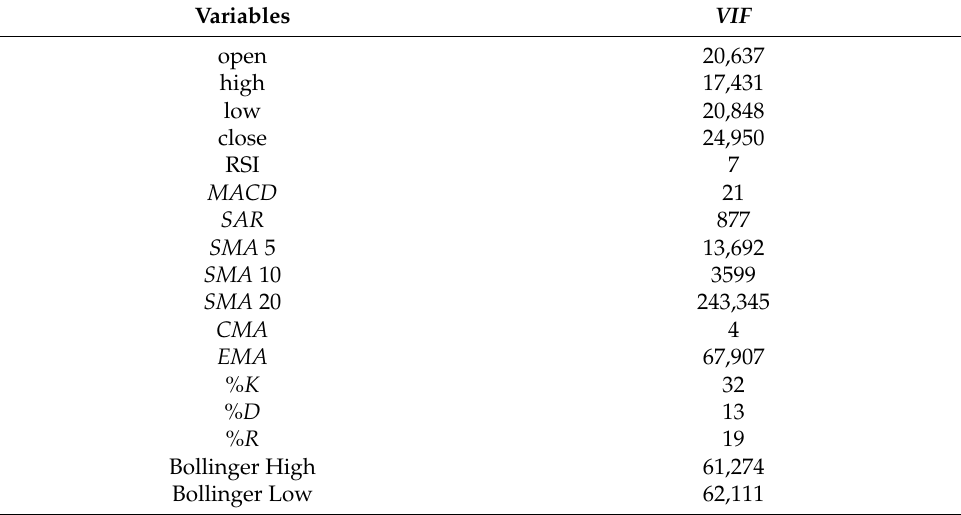
Table 1. Variation Inflation Factor Analysis for EUR/GBP dataset. Variables VIF open 20,637 high 17,431 low